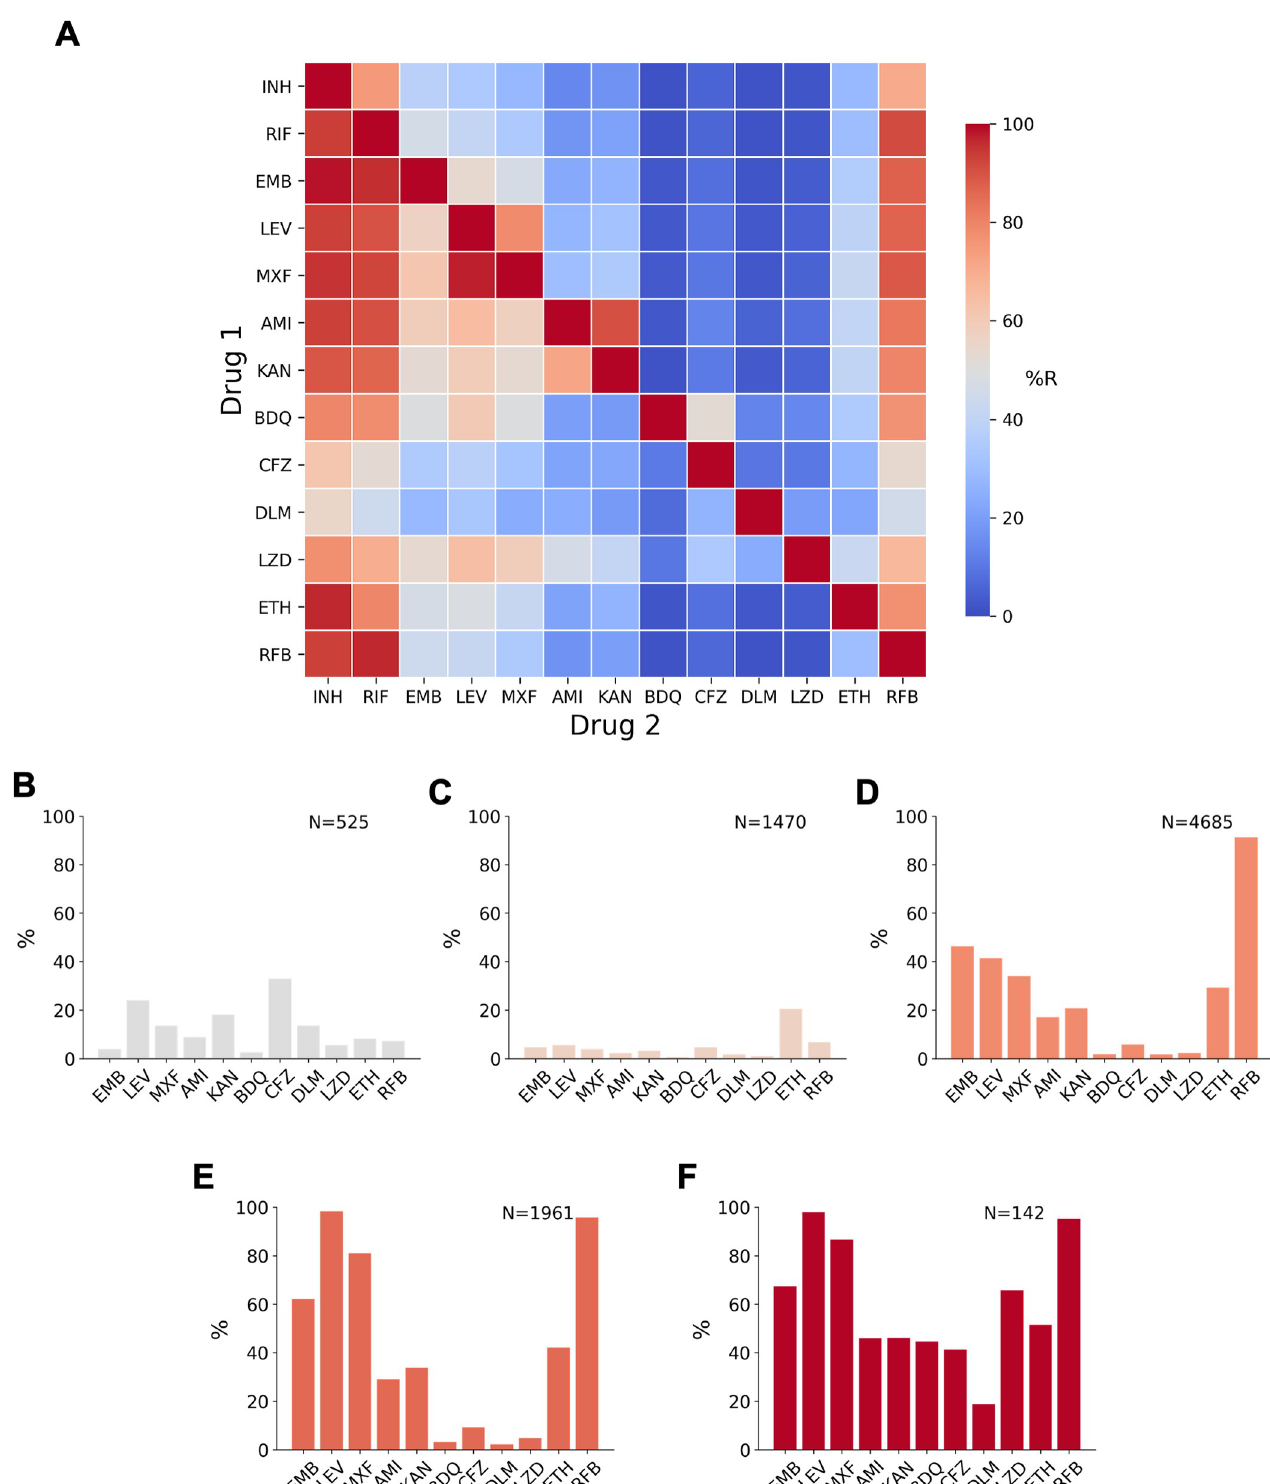
Fig 4. Co-occurrence of resistance to 1 drug conditional on resistance to another drug, or to resistance background. (A) The heatmap shows the probability of an isolate being resistant to Drug 2 if it is resistant to Drug 1, percentages are given in Table F in S1 File. (B-F) Percentage of isolates that are resistant to another of the 13 drugs in a background of (B) isoniazid susceptible + rifampicin susceptible (but resistant to at least one other antitubercular drug), (C) isoniazid resistant + rifampicin susceptible, (D) MDR/RR, (E) Pre-XDR, and (F) XDR. Only samples with definite phenotypes for RIF in MDR